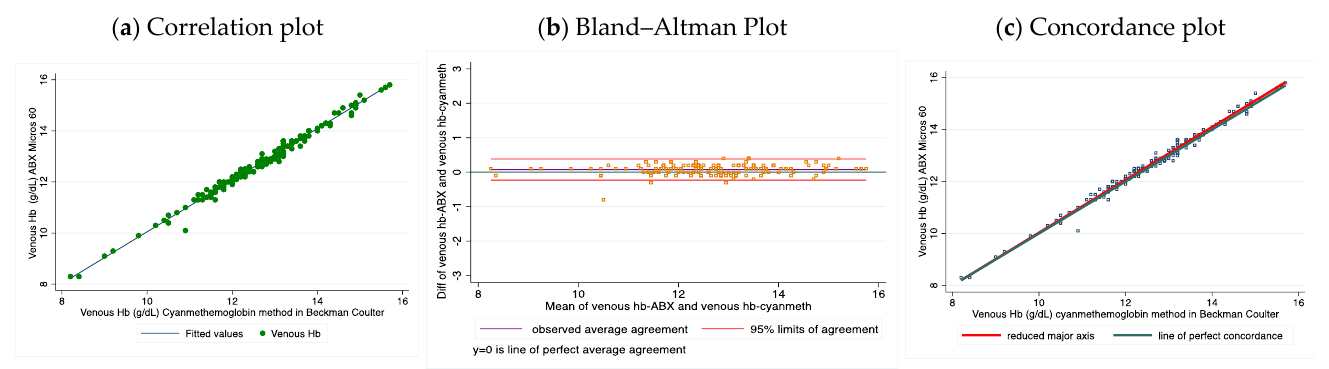
Figure 2. Correlation ( a ), Bland – Altman ( b ) and Concordance ( c ) plot for Hb concentrations by venous blood samples using the cyanmethemoglobin method and the HemoCounter ABX Micros 60.